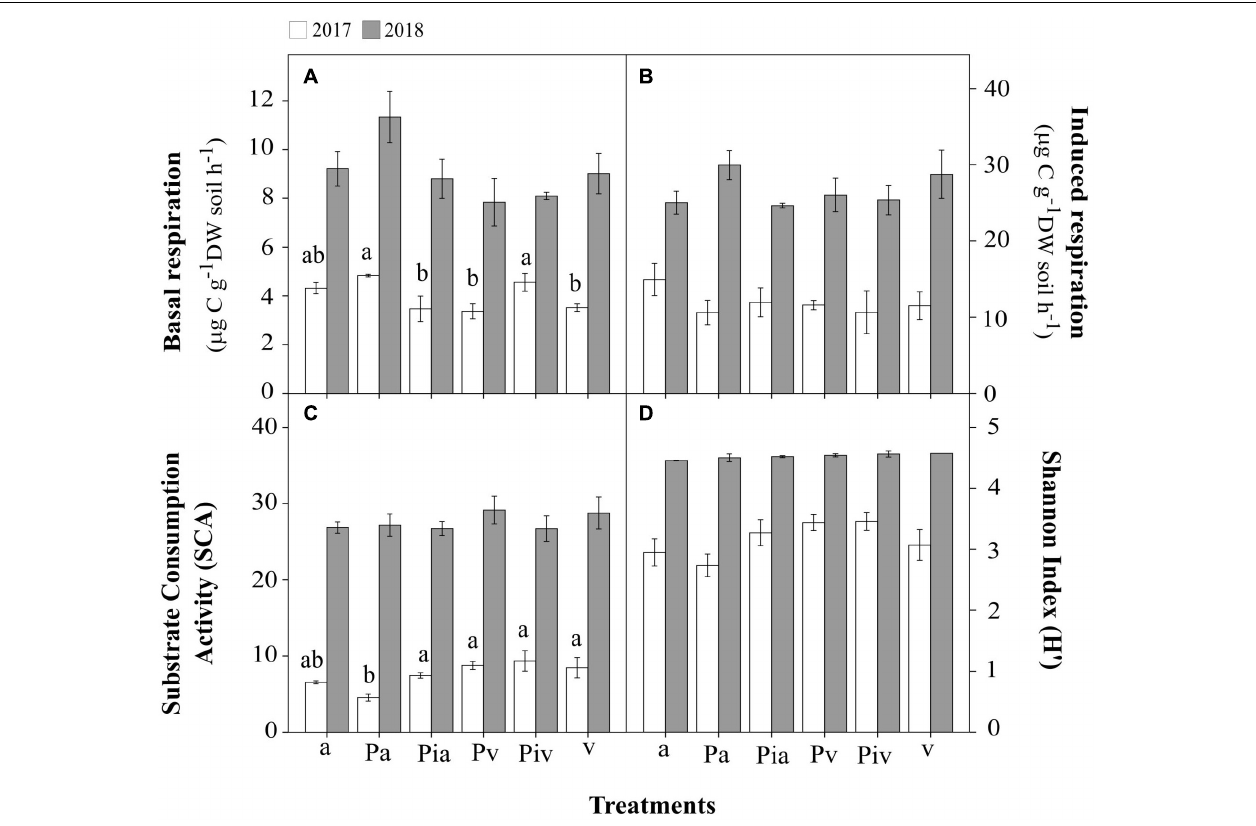
FIGURE 4 | Soil microbial activity, biomass, and bacterial functional diversity in 2017 (open bars) and 2018 (closed bars). Treatments: a, planting of alfalfa; Pa, intercropping of non-mycorrhizal poplars with alfalfa; Pia, intercropping of mycorrhizal poplars with alfalfa; Pv, planting of non-mycorrhizal poplars with spontaneous vegetation; Piv, planting of mycorrhizal poplars with spontaneous vegetation; v, spontaneous vegetation (unplanted control). Small letters indicate significant differences among treatments in 2017 (p < 0.05). (A) microbial activity in terms of basal respiration; (B) potentially active microbial biomass in terms of substrate-induced respiration; (C) Substrate Consumption Activity (SLA); (D) Shannon Index (H (cid:48) ) for bacterial functional diversity. Small letters indicate significant differences between treatments in 2017 ( p < 0.05). In 2018, there were no statistically significant differences between treatments. Each bar represents the mean ± SE ( n = 3).